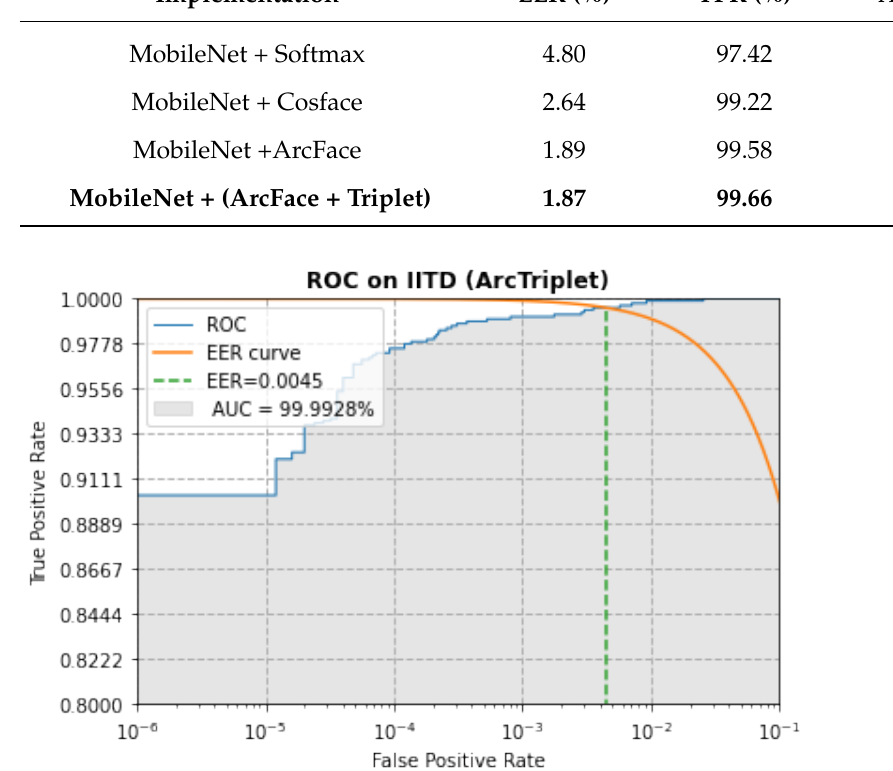
Figure 6. ROC curve of ArcFace + Triplet loss on